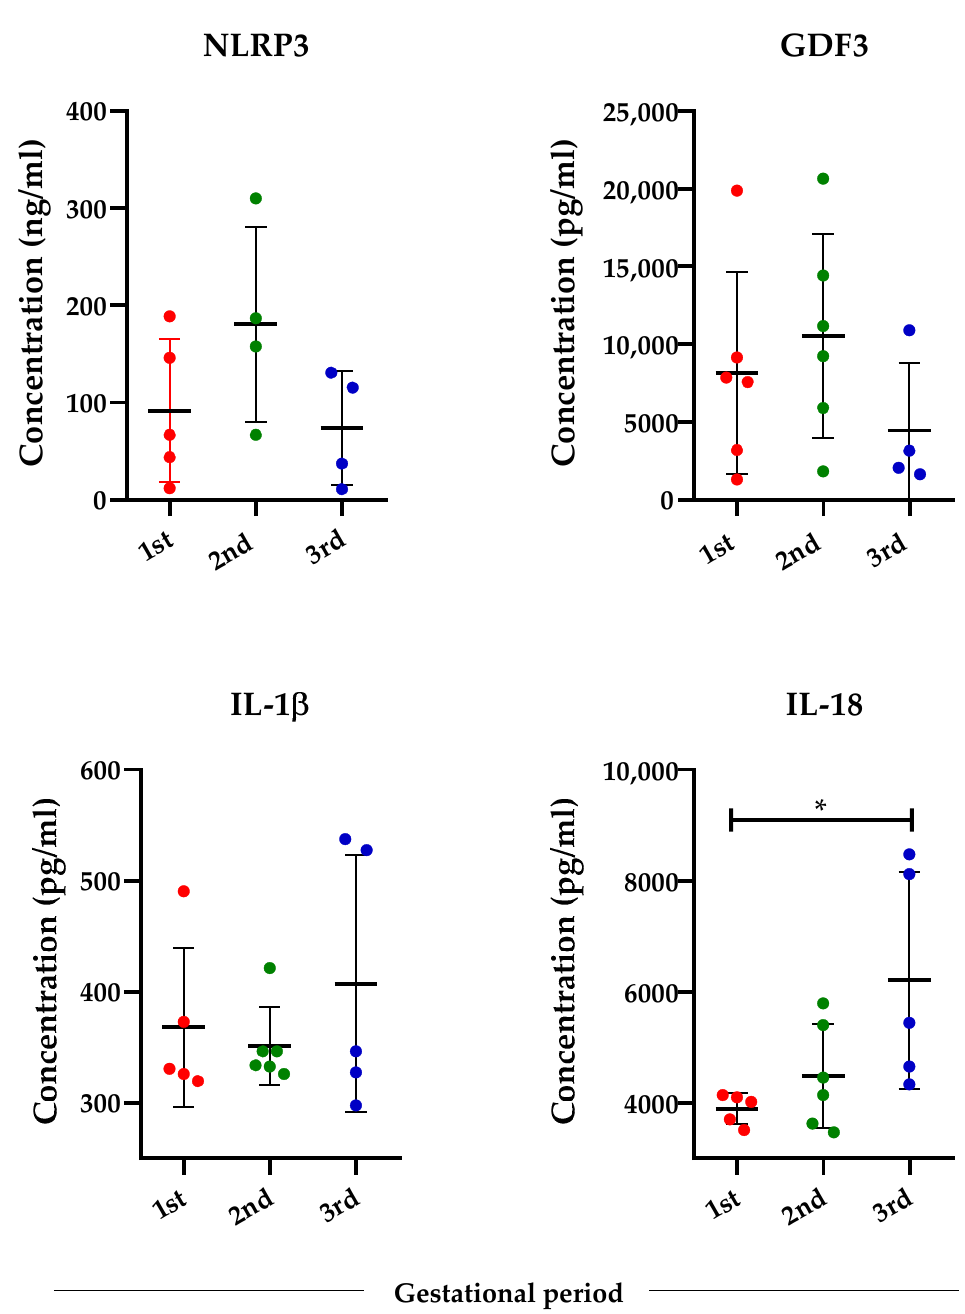
Figure 2. Serum analysis of GDF-3 and inflammasome-related markers according to the gestational period in the Pr ZIKV+ group. Analysis of serum concentration of NLRP3, GDF3, IL-1 β , and IL-18 in the first (1st, n = 6), second (2nd, n = 6), and third (3rd; n = 6) trimester of pregnancy. One-Way ANOVA with Tukey’s multiple comparison test. * p < 0.5.